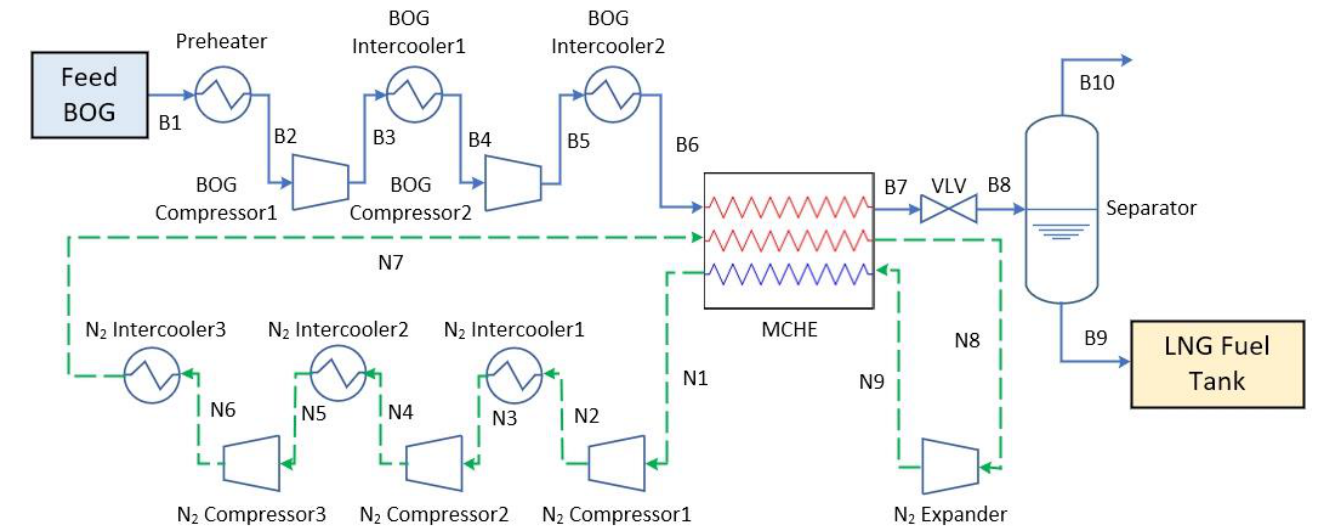
Figure 1. Schematic of the BOG re-liquefaction system presented in Kwak et al. [4].